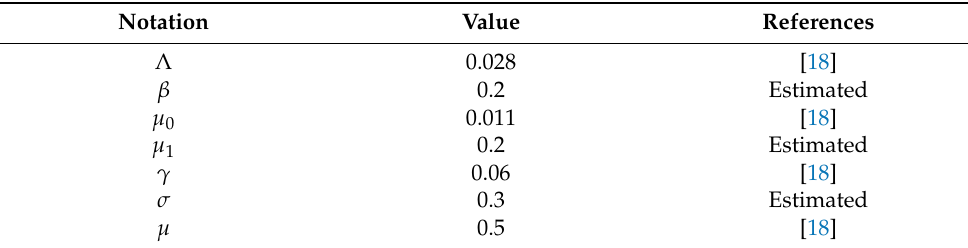
Table 3. Parameters value.